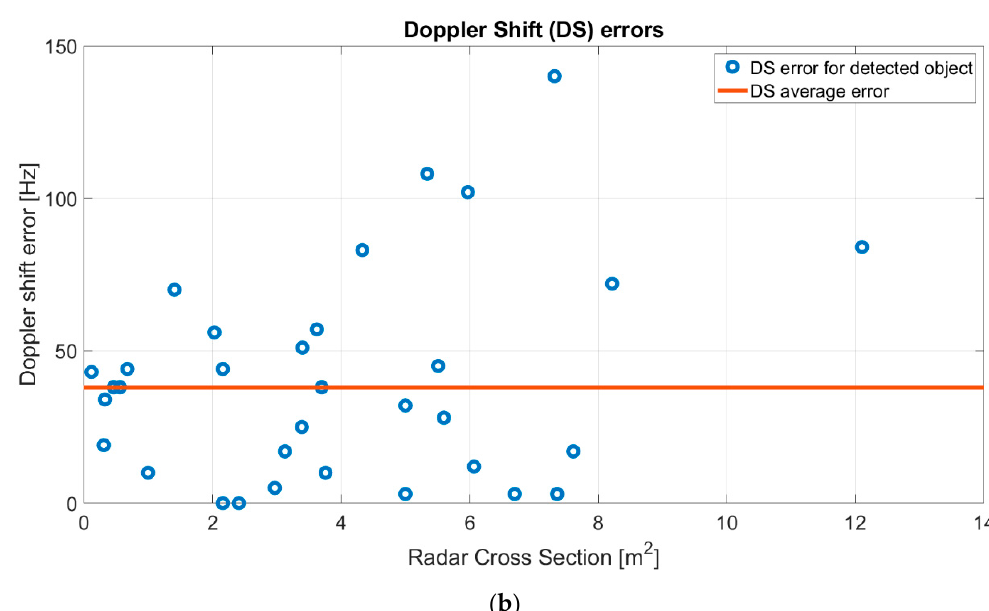
Figure 12. Measurement errors respect to estimated values: ( a ) slant-range error for each debris (blue points) and slant-range average error for all debris, equal to 100.189 m (red line); ( b ) Doppler shift error for each debris (blue points) and average error for all objects, equal to 37.95 Hz (red line).